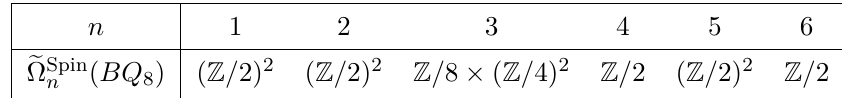
Table 6. The reduced spin bordism groups for BQ 8 in degrees lower than 7